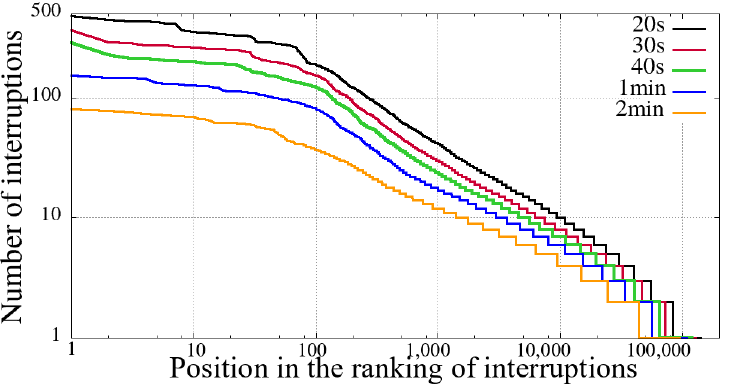
Figure 2. Interruption ranking from users of the Impeachment start session— Camara dos Deputados for different sizes of interruption—mobile